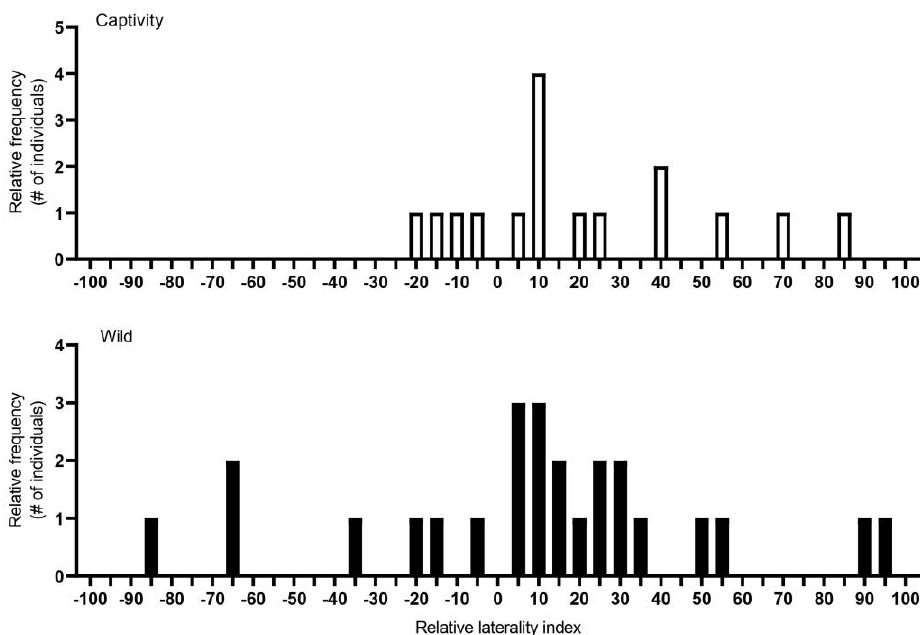
Figure 4. The relative frequency (Y-axis) of captive ( n = 15) and wild-caught ( n = 25) Damaraland mole rats’ ( Fukomys damarensis ) individual laterality along a laterality index (X-axis). The Y-axis scale represents the frequency of individuals with the same lateral index. The X-axis scale from the left represents right turning, with increased turning to the left as the index increased from − 100 to 100. A laterality index of 0 means that an individual turned left and right in equal amounts, demonstrating no turning biases. Black bars represent wild-caught animals and white bars represent animals in captivity. #—number.